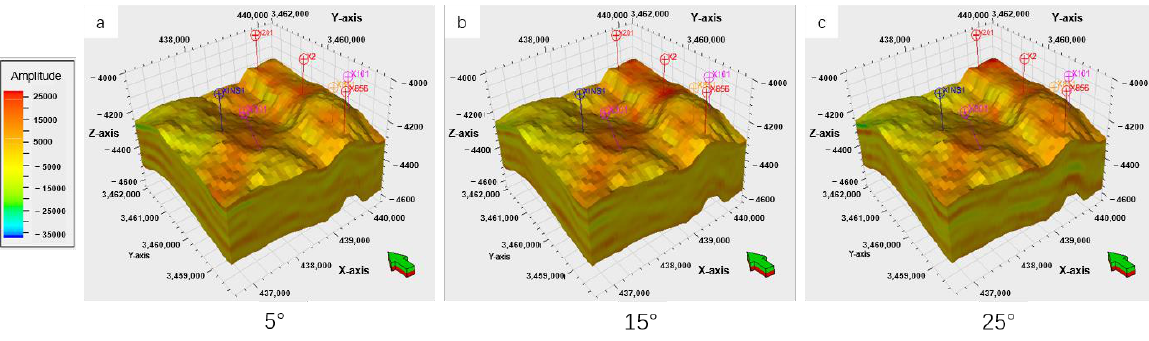
Figure 10. Pre-stack seismic track set for the inversion block: ( a ) 5°, ( b ) 15° and ( c ) 25°.